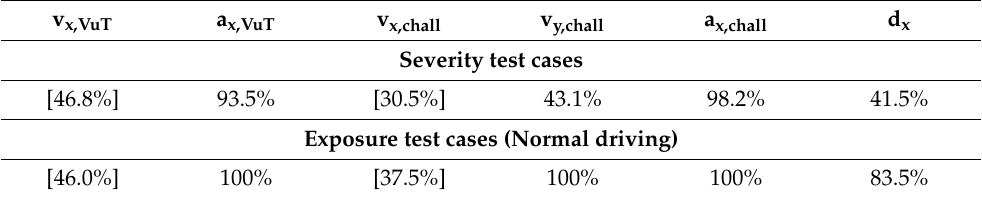
Table 6. Coverage ratios of severity and exposure test